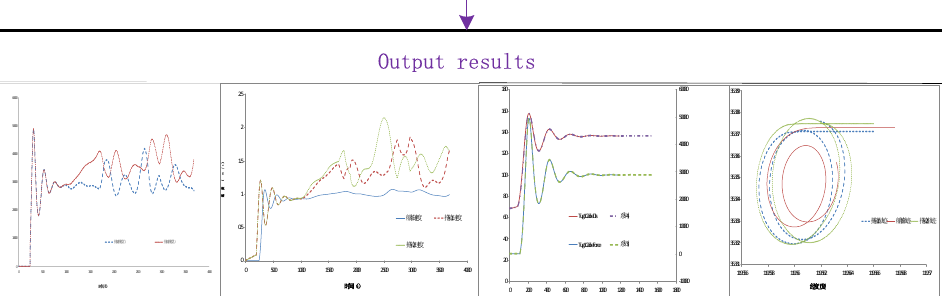
Figure 4. Flow chart of towing control